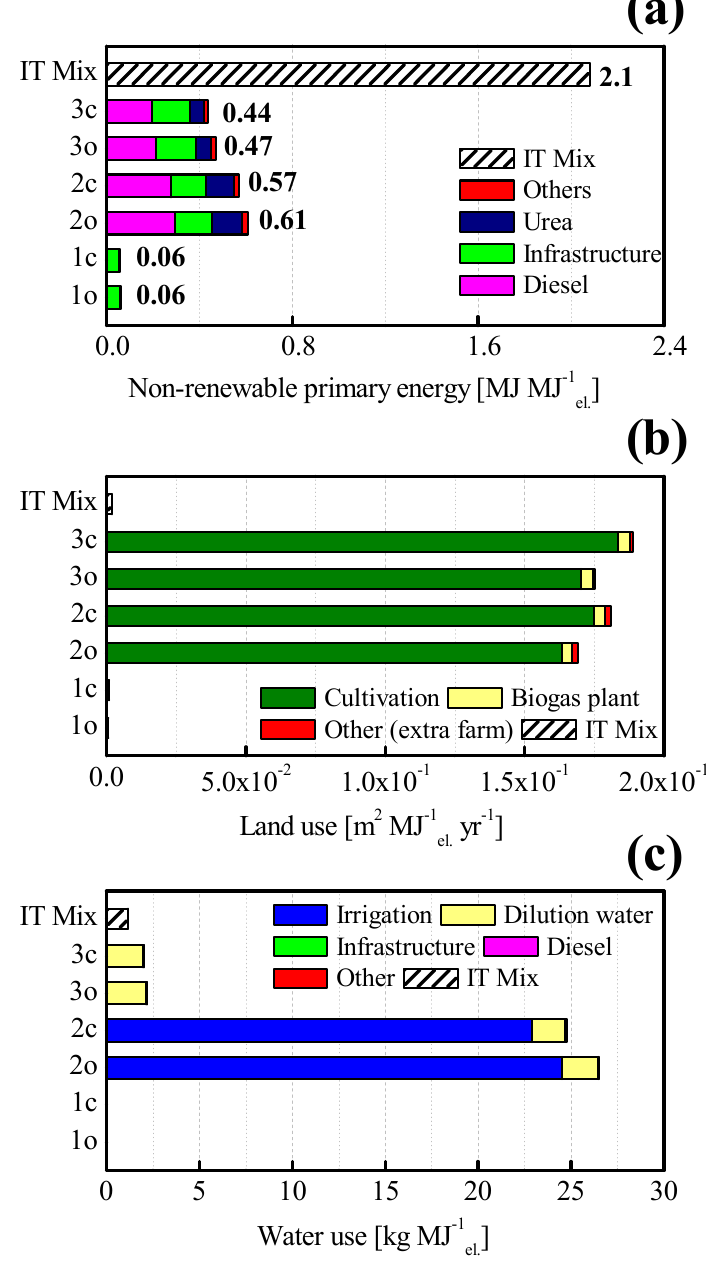
Figure 5. ( a ) Process contribution analysis of primary energy use from non-renewable sources (MJ·MJ − 1 el ). Results of the open-storage (1o, 2o, 3o), the closed-storage (1c, 2c, 3c) systems and the reference system ( i.e. , the Italian electricity mix), are included in the graph. The ERoEI can be calculated as the reciprocal of the primary energy consumption; ( b ) Land use in the various scenarios in m 2 ·yr − 1 ·MJ − 1 el ; ( c ) Freshwater consumption in the various scenarios in kg·MJ − 1 el